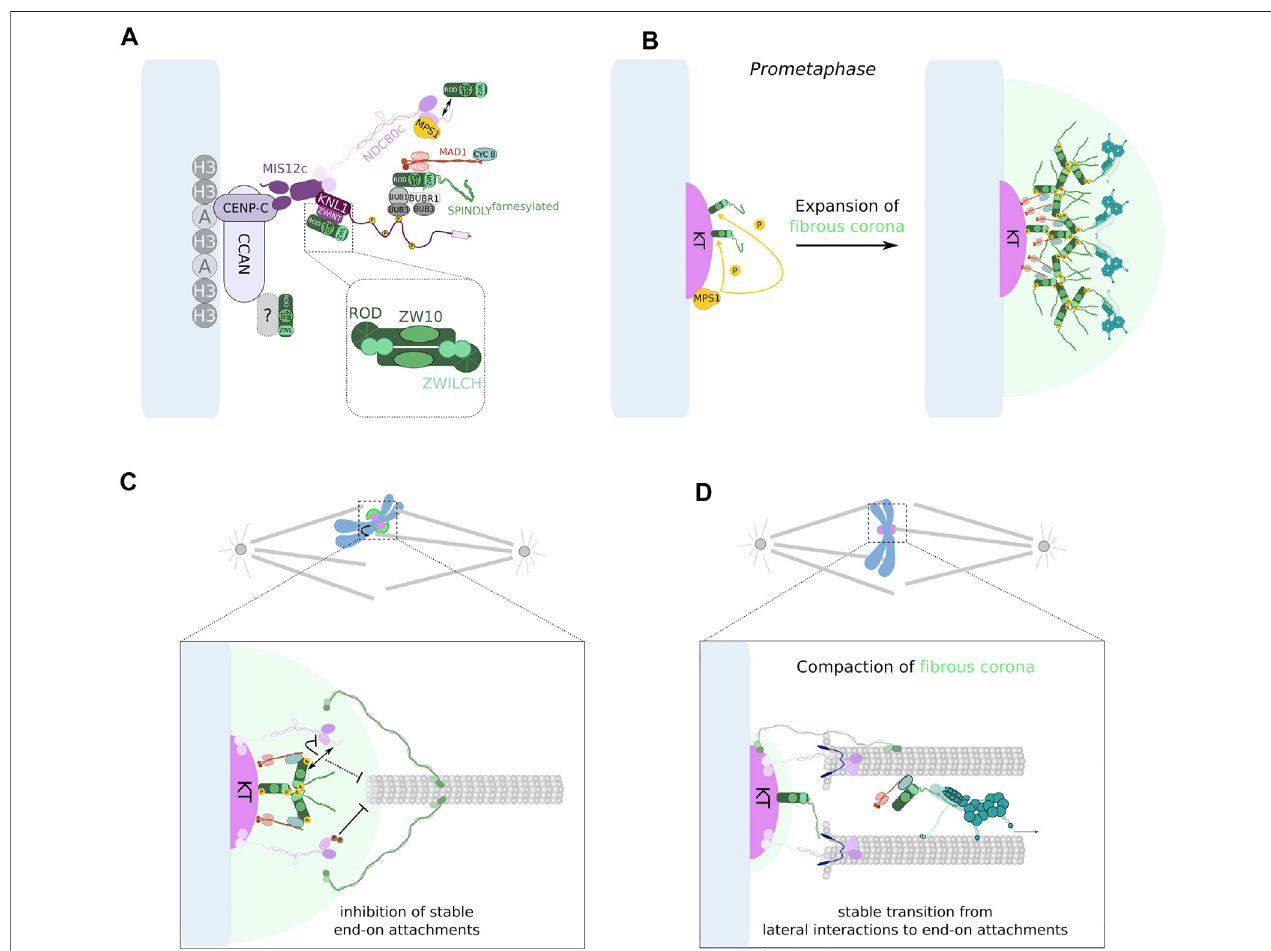
FIGURE 6 | RZZc:SPINDLY-dependent regulation of KT size dynamics and KT-MT attachment stability. (A) Localization of the RZZc to the outer KT requires differentbindingpartners,includingZWINTandBUB1.UnlikeRZZc:ZWINT,adirectinteractionbetweentheRZZcandBUB1hasnotbeendemonstratedyet.Moreover, additional binding partners for the RZZc are likely to exist, but still remain unidenti fi ed ( “ ? ” ). It has been proposed that NDC80 may constitute an RZZ binding partner, as ROD was found to interact with the N-terminal tail in NDC80 in a yeast two hybrid assay. Furthermore, the RZZc directly recruits SPINDLY to KTs. In human cells, thisinteractionrequiresSPINDLYtobefarnesylatedatitsC-terminalCAAXmotif(SPINDLY farnesylated ). (B) Expansionofthe fi brouscoronaduringprometaphaseisdriven by the RZZc:SPINDLY farnesylated and is stimulated by MPS1-dependent phosphorylation of ROD. Importantly, SPINDLY also contributes to the subsequent compaction of the fi brous corona by recruiting DYNEIN:DYNACTIN. (C) The localization of different MAPs, including DYNEIN and CENP-E, to the fi brous corona facilitates initial MT capture. However, the presence of an expanded corona can inhibit the formation of stable load-bearing end-on attachments. The decreased stability of end-on attachments may result from the inhibitory action of the RZZc over NDC80/HEC1. (D) Compaction of the fi brous corona enables the conversion of lateral contacts between KTs and MTs into stableend-on attachments. DYNEIN:DYNACTIN has an critical function in ef fi ciently stripping the RZZc away from KTs, thereby contributing to relieve its inhibitory activity towards KT-MT end-on attachments. DYNEIN:DYNACTIN-dependent disassembly of the fi brous corona also leads to the removal of SAC proteins and silencing of the mitotic